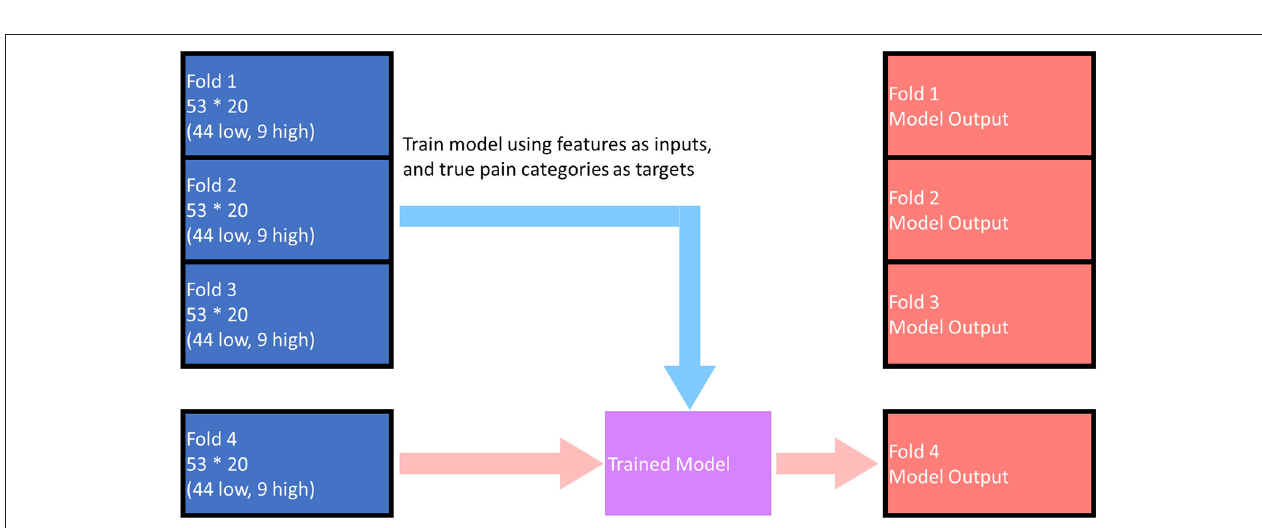
FIGURE 3 | Illustration of the cross-validation training and evaluation process. The above figure demonstrates the process for i = 4, when model outputs for fold 1 ∼ fold 3 has already been calculated. The model outputs for each fold (any one of the red folds in the figure) were predicted by the model trained by data in the other 3-folds. The overall performance of the model was evaluated based on the red folds in the